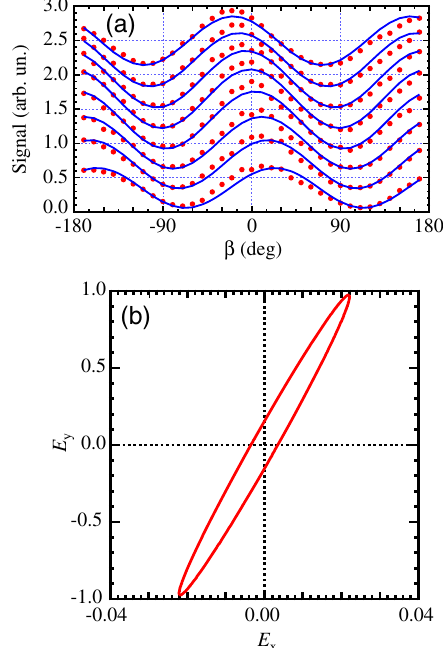
FIG. 9. (a) Complete data set of the scans for 26-nm vertical polarization. Red points report the average signal for each value of α and β . Blue lines show the fitted curves obtained from the various β scans, allowing the retrieval of the FEL Stokes parameters. (b) Polarization ellipse reconstructed with the Stokes parameters obtained from the fit. Note the expanded horizontal scale.